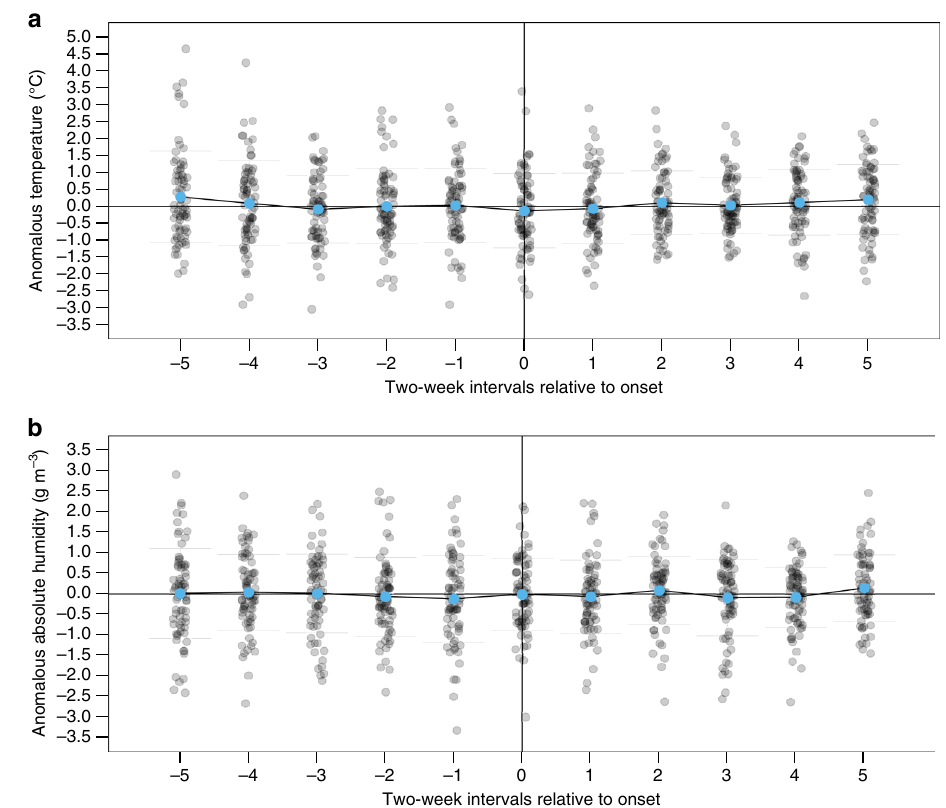
Fig. 2 Climatic conditions around epidemic onset. a Anomalous temperature T ′ and b absolute humidity AH ′ prior to and after epidemic onset across all fi ve cities. Epidemic onset is marked by the vertical line at 0. For the earliest-onset epidemic in each season and city (15 years × 5 cities = 75 epidemics), T ′ and AH ′ for each time point are represented by grey points: a point below the horizontal line denotes that the value is lower than the 31-year city-speci fi c mean. Blue points show the mean T ′ and AH ′ for that 2-week period for all epidemics across all cities within the study period. There were no periods with statistically signi fi cant reductions ( P < 0.05; Non-parametric bootstrapping) in T ′ or AH ′ from the 31-year